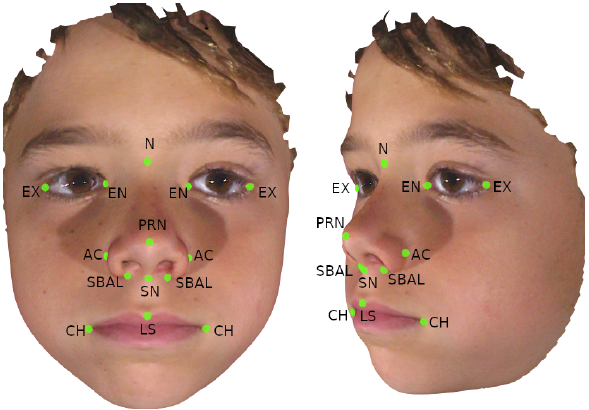
Figure 2. The standard anatomical positions of the landmarks used to define the distance